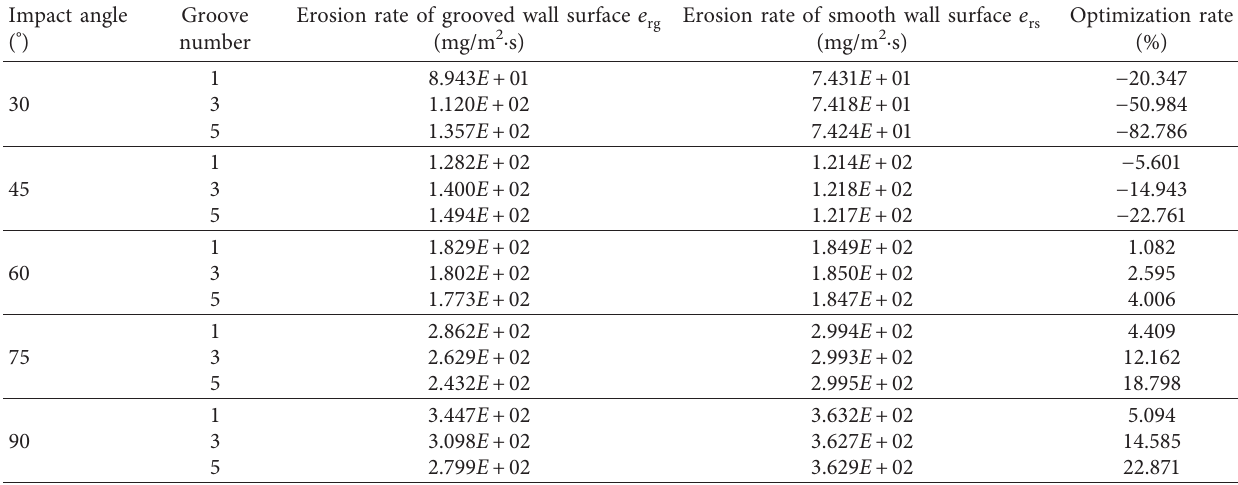
Table 3: Erosion rates of grooved and smooth wall surfaces under different groove numbers and impact angles. Impact angle